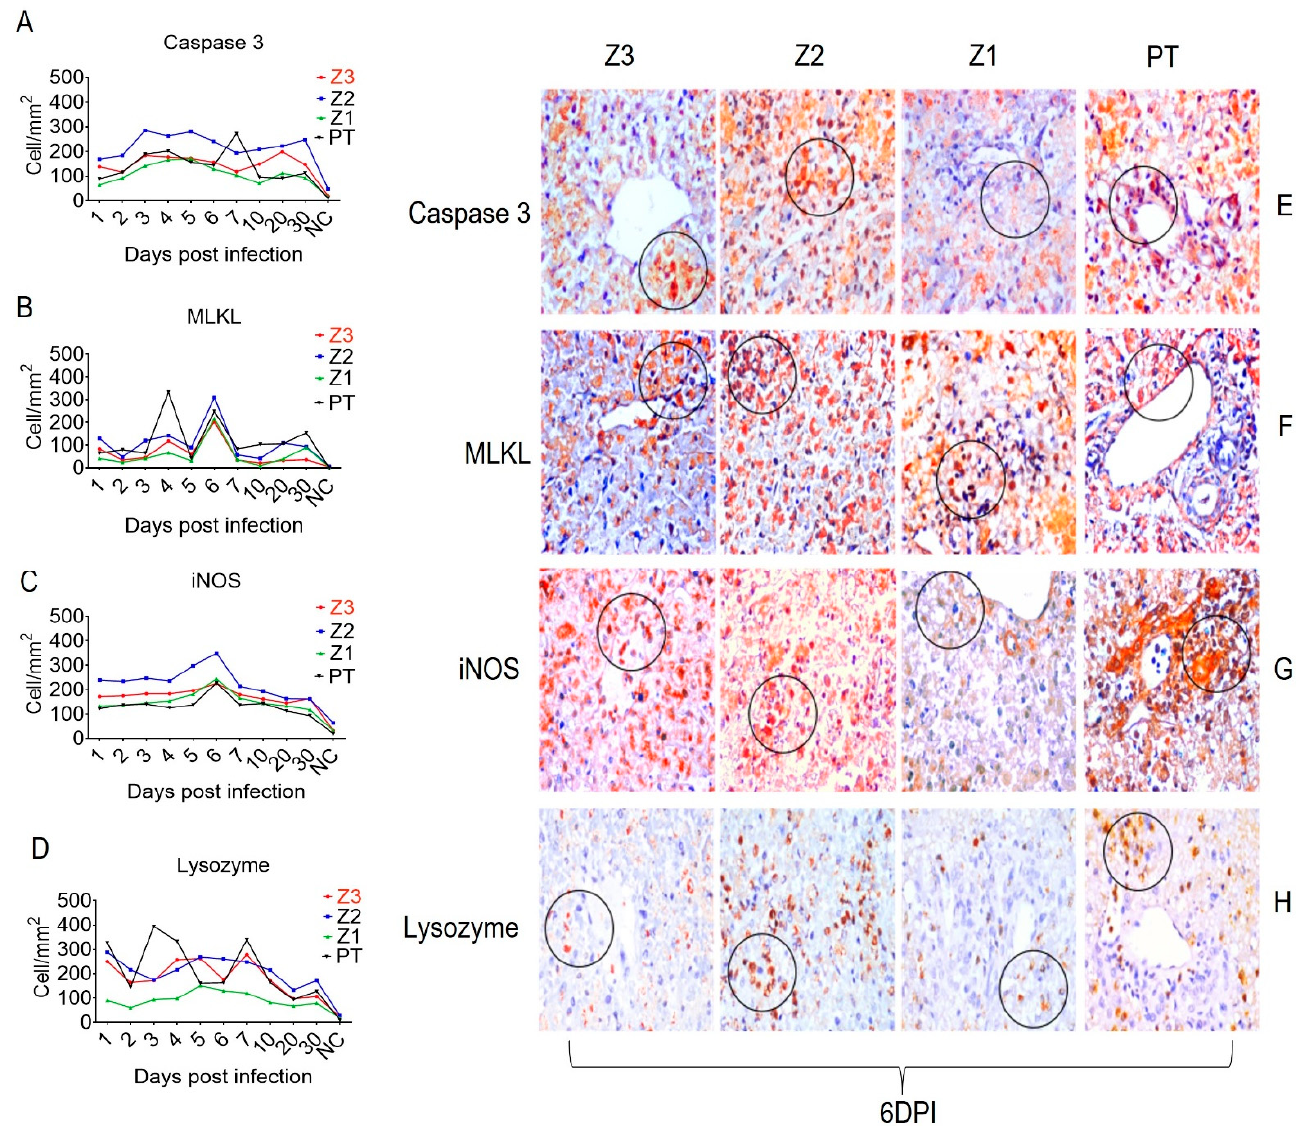
Figure 4. Quantitative immunohistochemical analysis of specific markers in Z3, Z2, Z1 and PT in the hepatic parenchyma of squirrel monkeys ( Saimiri spp.) infected with YFV. Circles represent areas expressing higher immunostaining cells in different hepatic areas. ( A ) Caspase 3 expression. ( E ) Immunostaining for Caspase 3 in hepatocytes (E-Z3), (E-Z2), (E-Z1) and bile duct (E-PT). ( B ) MLKL expression. ( F ) Immunostaining for MLKL in hepatocytes and inflammatory infiltrate (F-Z3), (F-Z2) inflammatory infiltrate, (F-Z1) in hepatocytes, (F-PT) in hepatocytes. ( C ) Expression of iNOS. ( G ) Immunostaining for iNOS in inflammatory infiltrate (G-Z3), (G-Z2) in hepatocytes, (G-Z1) hepatocytes, (G-PT) bile duct and inflammatory infiltrate. ( D ) Lysozyme Expression. ( H ) In inflammatory infiltrate (E-Z3), (E-Z2), (H-Z1) in Kupffer cells, (H-PT) in inflammatory infiltrate at 6 dpi.